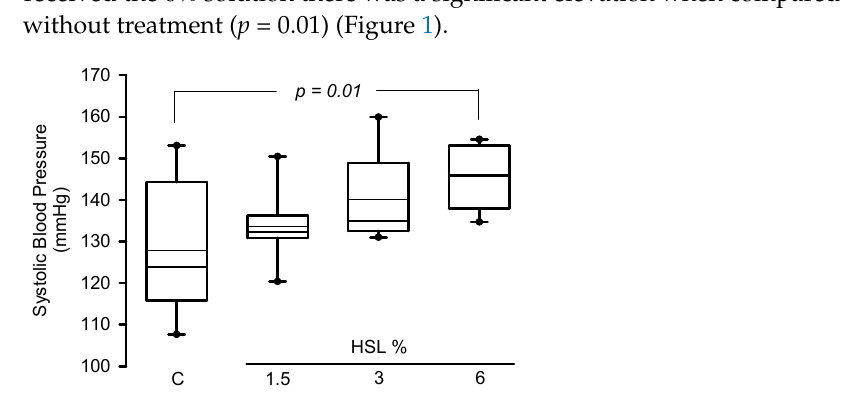
Figure 1. Systolic blood pressure in experimental rats ( n = 8). The data are presented as median and maximum and minimum ranges (interquartile range 25th percentile, 75th percentile by the type distribution. Additionally, the mean and standard error values of the systolic blood pressure per group expressed in mmHg were as follows: Group 1 = 127.8 ± 5.6, Group 2 = 133.7 ± 2.9, Group 3 = 140.1 ± 3.6, and Group 4 = 145.5 ± 2.6. Abbreviations HSL = Hibiscus Sabdarrifa